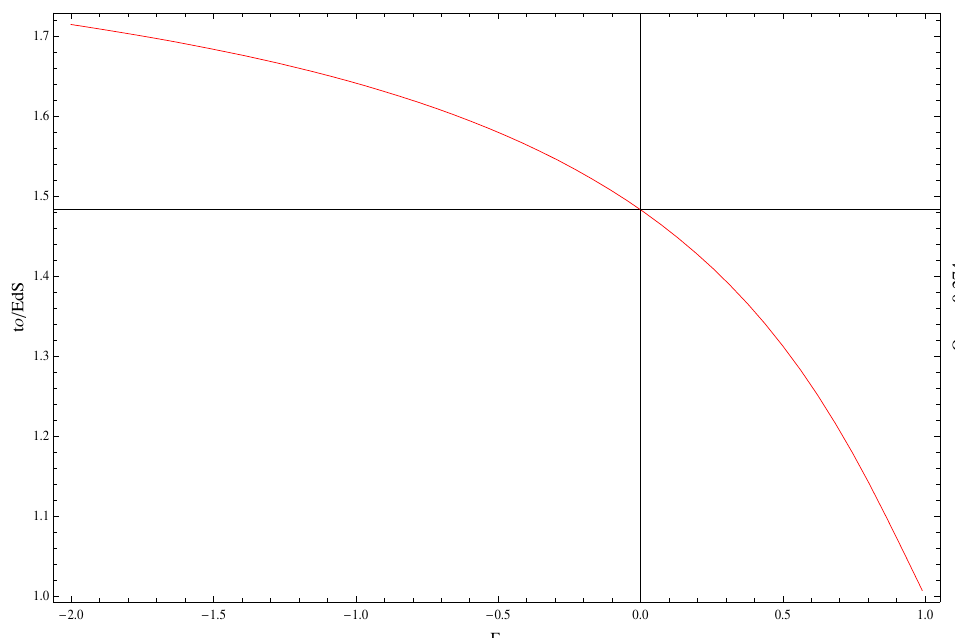
Figure 2. The age of the polytropic DM model, t 0 , in units of t EdS , as a function of the polytropic exponent Γ < 1 (red solid line). Notice that, for every Γ < 1, we have t 0 > t EdS , with t 0 approaching t EdS only in the isothermal ( Γ → 1 ) limit. The horizontal solid line denotes the age of the universe in the Λ CDM-like ( Γ = 0 ) limit of the polytropic DM model, i.e., t 0 = 1.483 t EdS